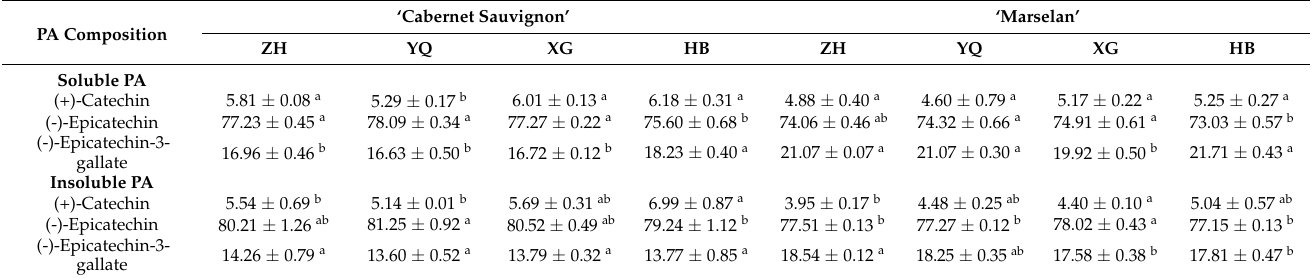
Table 4. Percentage of flavan-3-ol monomers (%) in the PA composition units of seeds from different